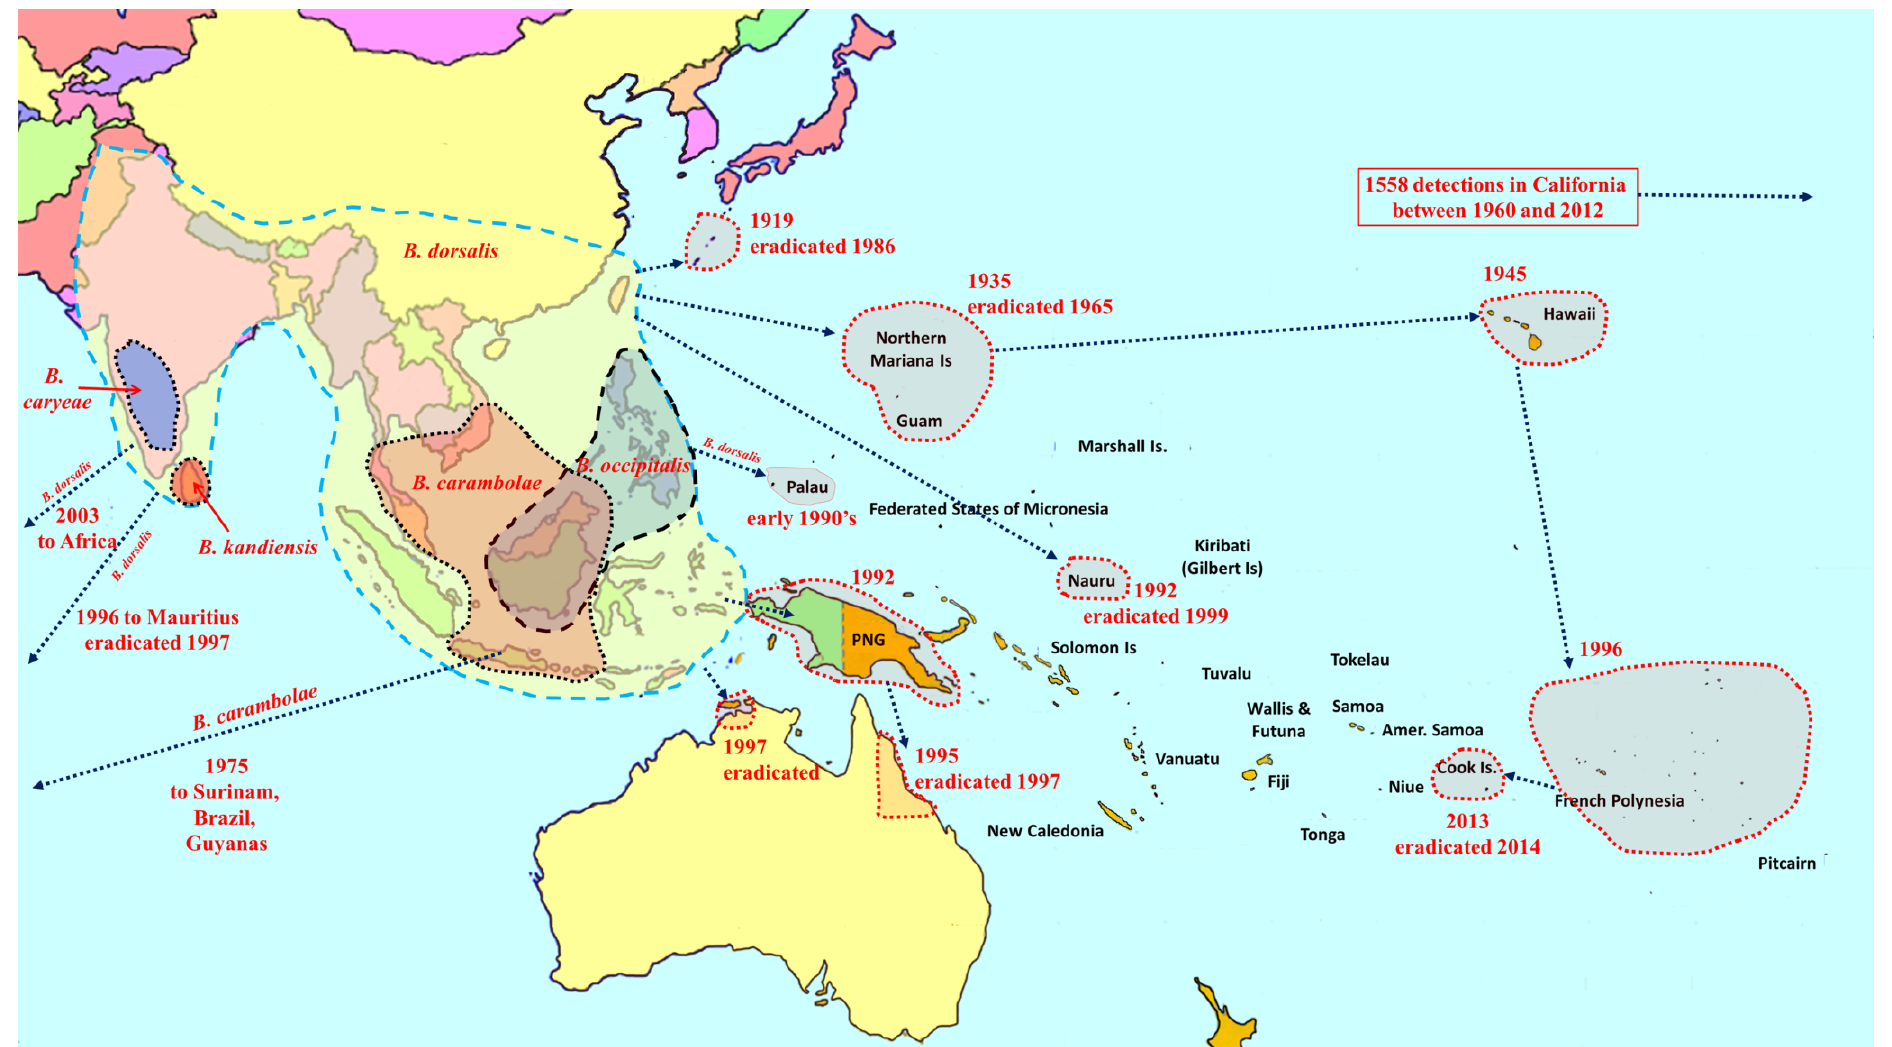
Figure 1. Distribution and invasion history of species in the Oriental fruit fly ( Bactrocera dorsalis )